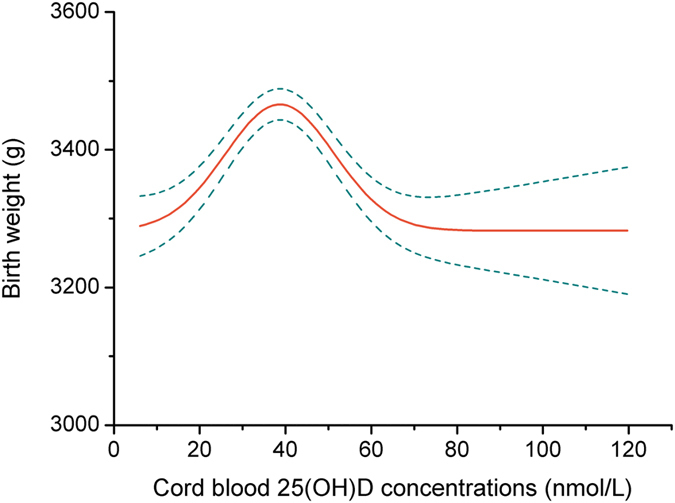
Unadjusted association of cord blood 25(OH)D concentrations and birth weight using Gaussian curve-fitting model with knot at 40 nmol/L (P < 0.001).The solid line represents the trend for changes in birth weight in mean values across increasing cord blood 25(OH)D concentrations and dotted lines represent the 95% confidence interval.